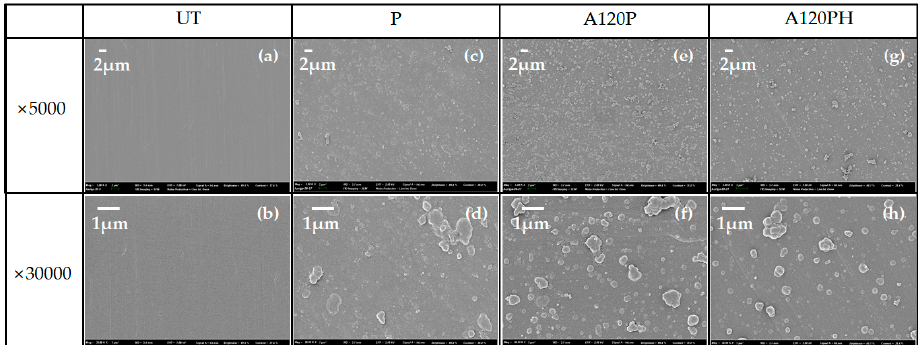
Figure 3. FE-SEM images for untreated sample (UT) ( a , b ), polypyrrole coated PVDF film without alkaline treatment (P; c , d ), polypyrrole coated PVDF film after alkaline treatment for 120 min (A120P; e , f ), and hydrophobic coated PVDF film after alkaline treatment for 120 min and polypyrrole coating (A120PH; g , h ).